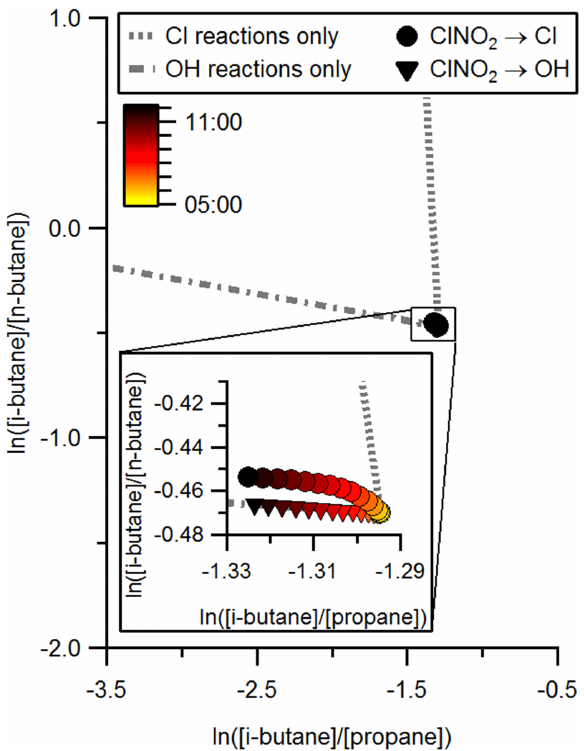
Fig. 6. MCM-calculated VOC tracer ratio evolution ( i -butane, n - butane, and propane) using Pasadena pre-sunrise measured concen- trations of radical precursors and VOCs (Condition Set 3a), then changing the photolysis of ClNO 2 to produce OH instead of Cl (Condition Set 3b). Scale is identical to that in Fig. 2a and expanded in the